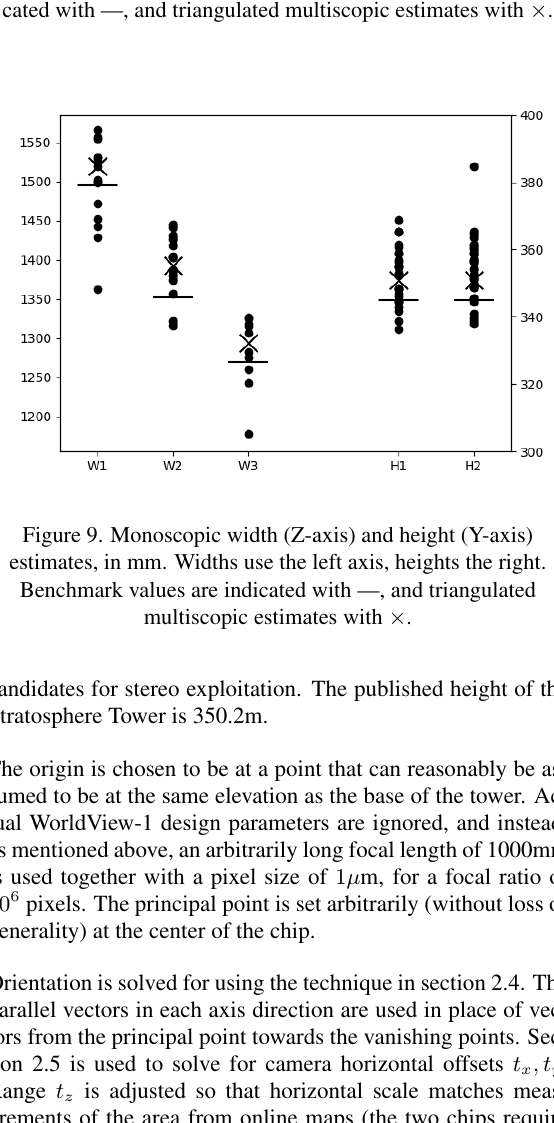
Figure 8. Monoscopic length (X-axis) estimates, in mm. L1 and L2 use the left axis, L3 the right. Benchmark values are indi- cated with —, and triangulated multiscopic estimates with × .